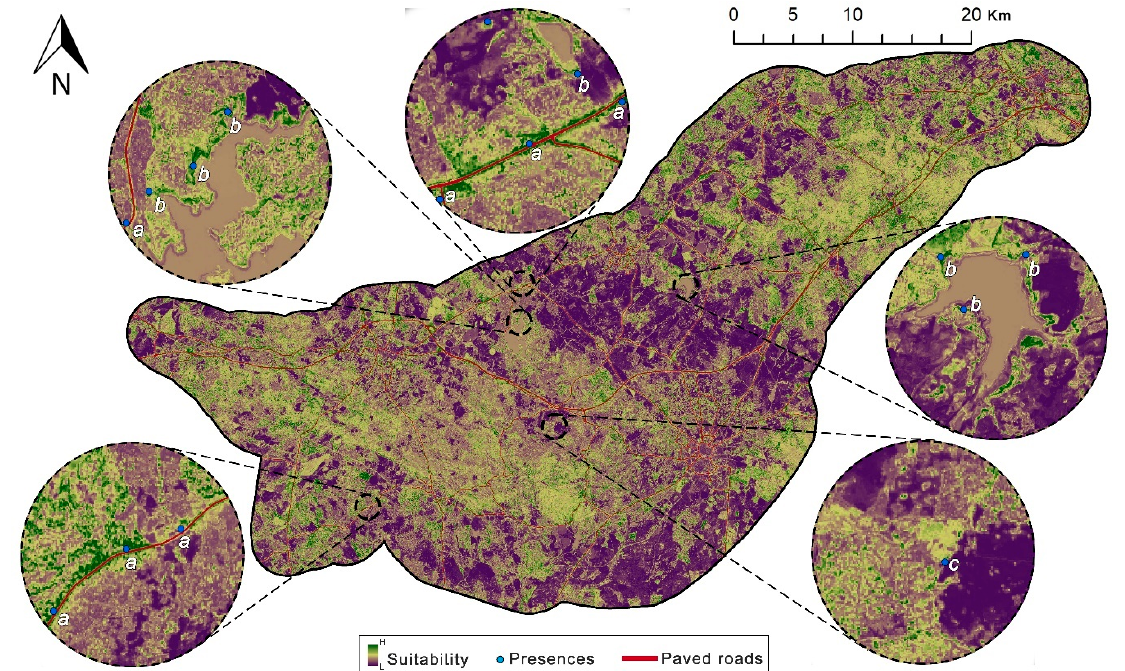
Figure 4. High-resolution Cabrera vole habitat suitability map in Southern part of Portugal, layered with paved roads and presences (blue dots). Zoomed areas are depicted as examples of identified sites of conservation interest namely (a) road verges, (b) pond banks, and (c) field margins. Purple areas: Low suitability; Green areas: high suitability).